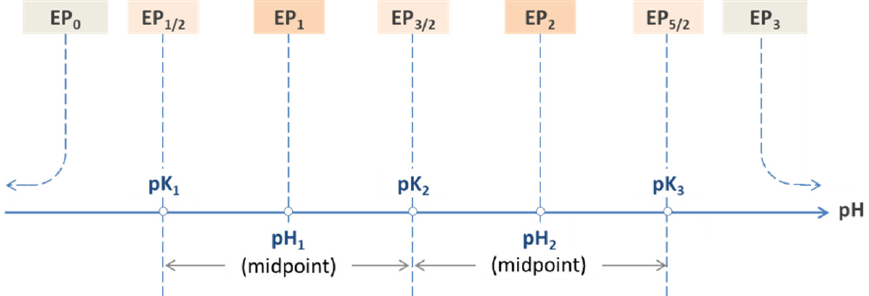
Figure 13. Equivalence points of a triprotic acid H 3 A arranged on the pH scale. Table 3. Internal equivalence points (based on pK values in Table 1).